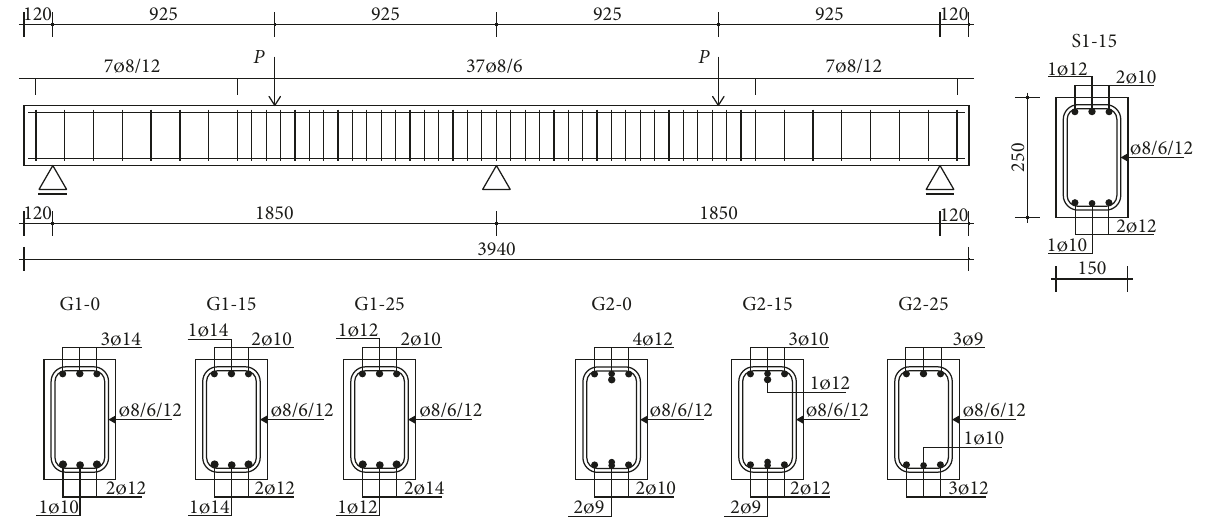
Figure 1: Geometry and reinforcement details for tested beams (all dimensions are in mm).